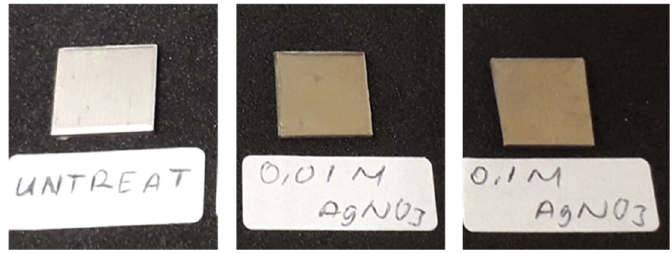
Figure 1. Photo of untreated Ti, Ag coated Ti from 0.01 mol/L AgNO 3 , and Ag coated Ti from 0.1 mol/L AgNO 3 .